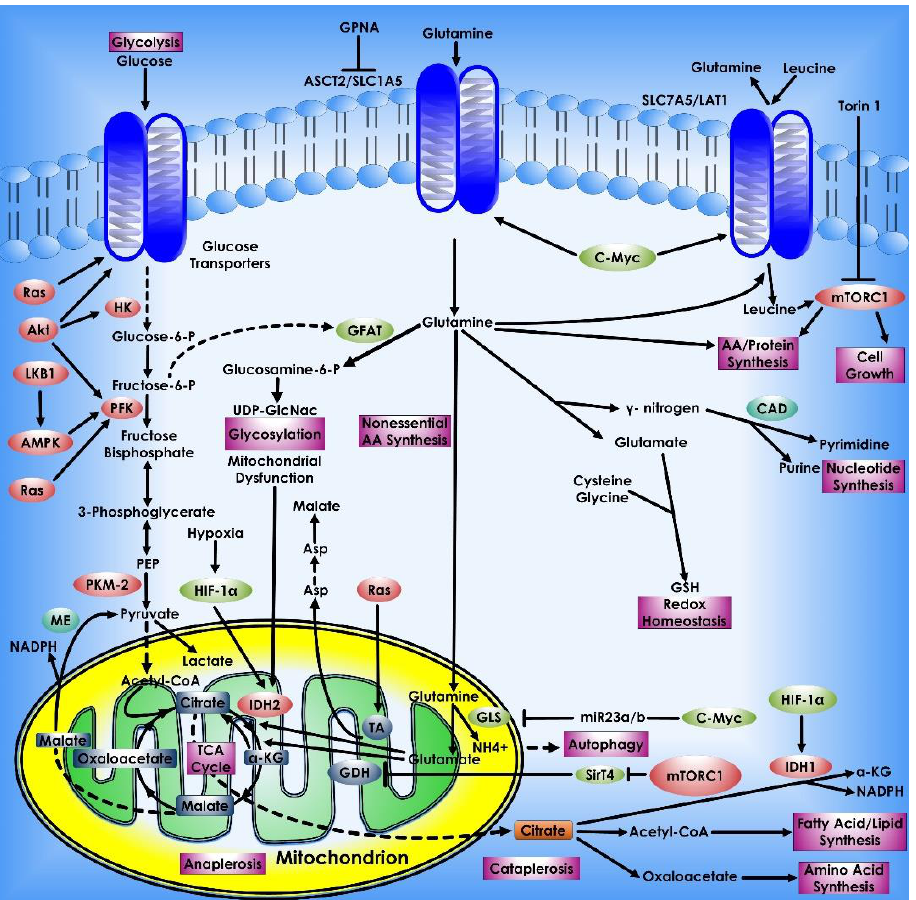
Figure 9. Glutamine metabolism in Cancer Cells. Glutamine is a key metabolic fuel that assists rap-